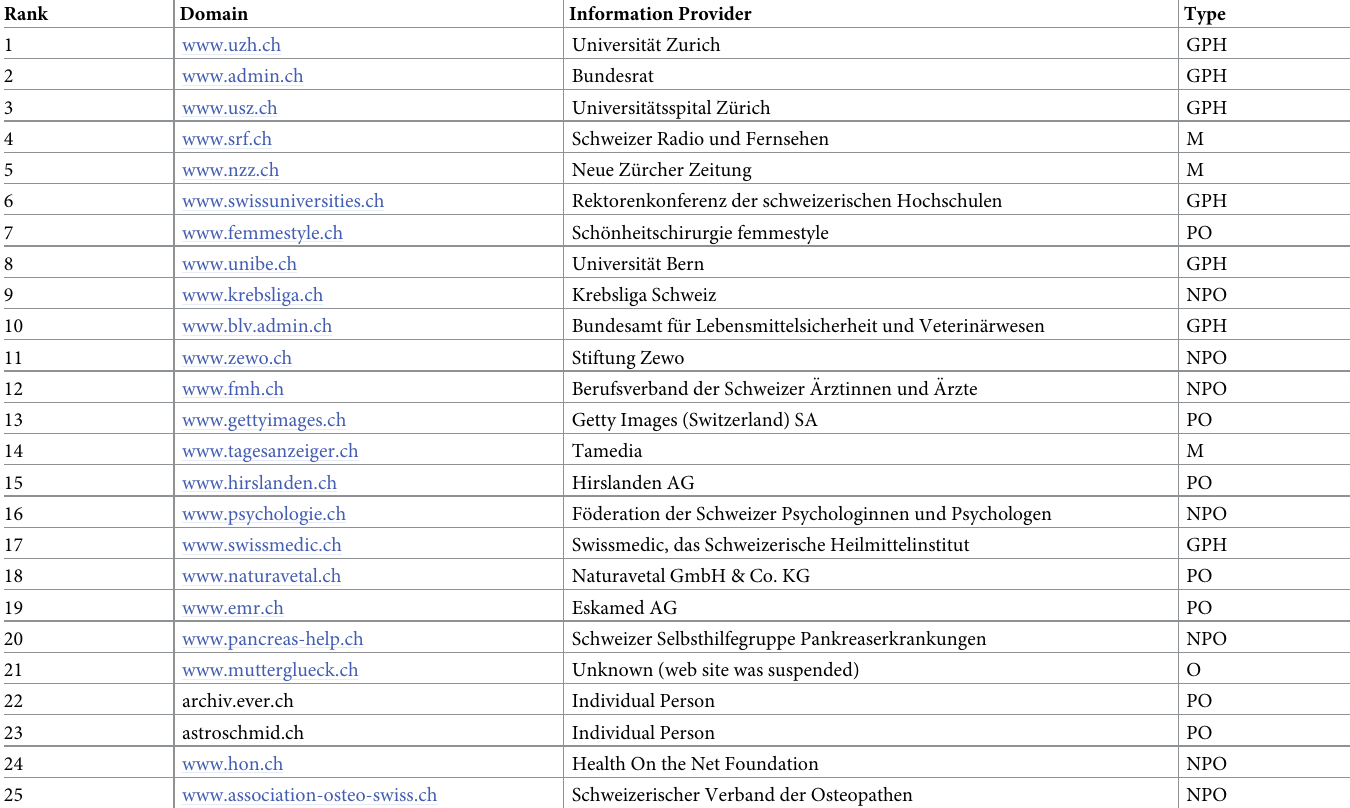
Table 3. Domains of 25 top-ranked web sites for ccTLD “.ch” with their respective information provider according to PageRank. Rank Domain